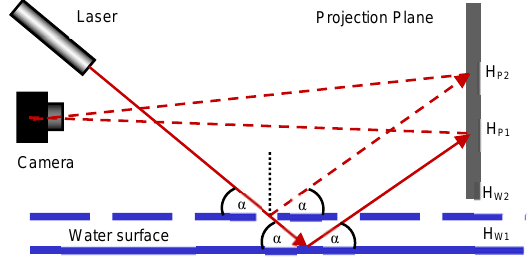
Figure 3: Optical triangulation using a vertical projection plane